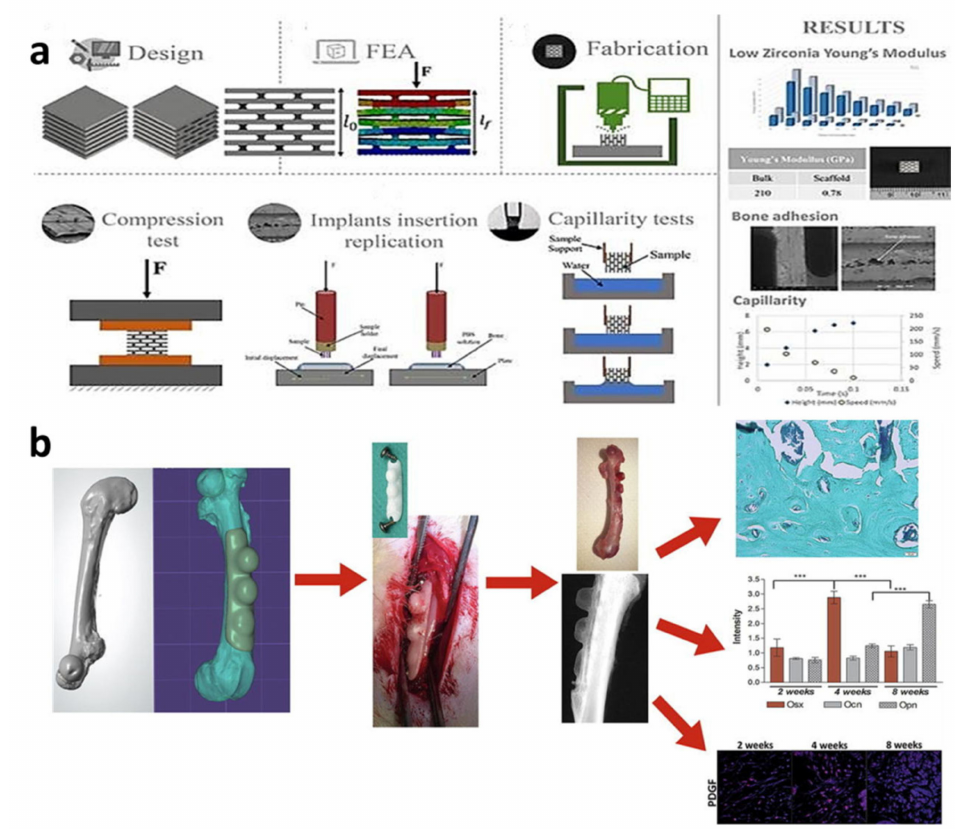
Figure 5. ( a ) Schematic of zirconia scaffolds designed via a CAD/CAM model. Image used from Marques et al. [69] reprinted with permission from Elsevier, copyright© 2019. ( b ) Detailed